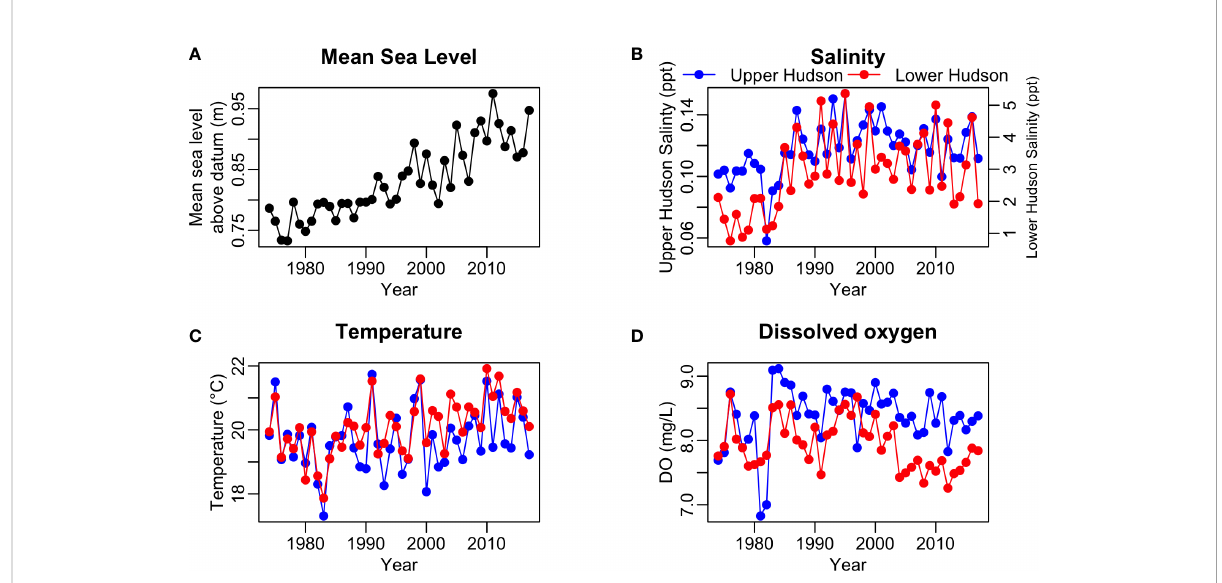
FIGURE 3 The time series of (A) the averaged sea level in meters above station datum at the Battery station in New York City (https://tinyurl.com/ y857uf97), (B) the averaged salinity, (C) water temperature, and (D) dissolved oxygen in the upper and lower Hudson River Estuary during May- July in each